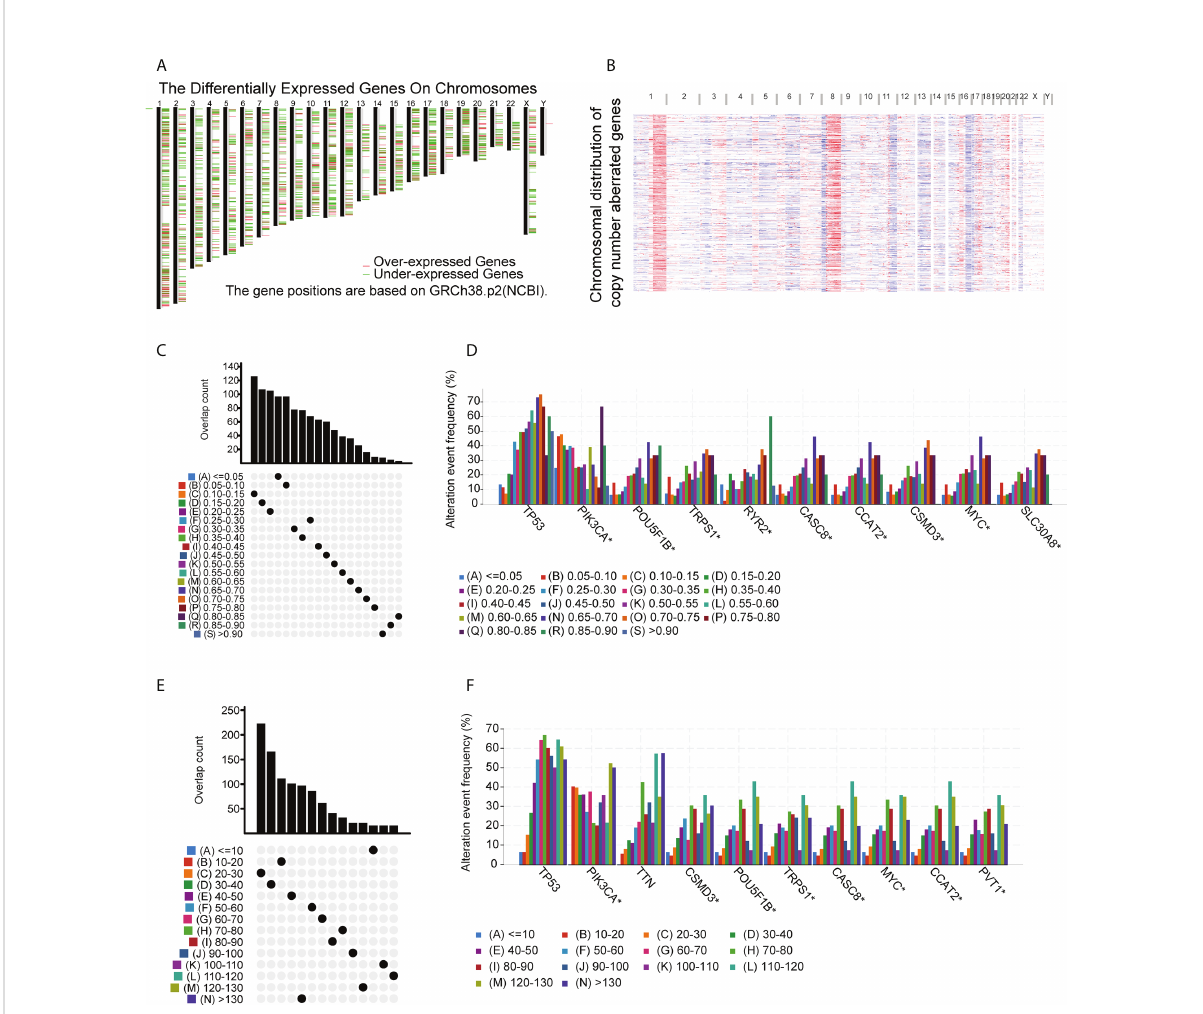
FIGURE 1 Potential BC tumor-associated antigens. (A) Chromosomal locations of differentially expressed genes. (B) Chromosomal locations of genes with aberrant copy numbers. (C-F) Potential tumor-associated antigens. Overlap between mutated genes in the genome fraction altered group (C) and the mutation count group (E) . Top genes in the genome fraction altered group (D) and mutation count group (F) . *